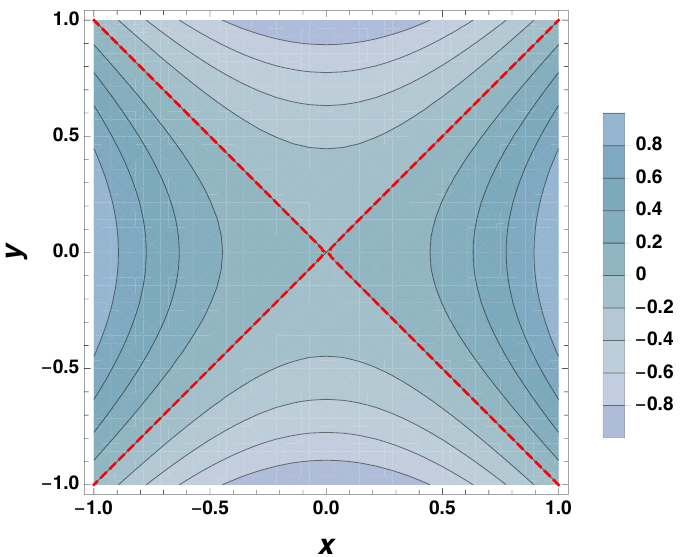
Figure 1. Contour plot of ψ 0 ∝ ( x 2 − y 2 ) as a function of ( x , y ) in arbitrary unit. Dashed red line represents the contour ψ 0 =